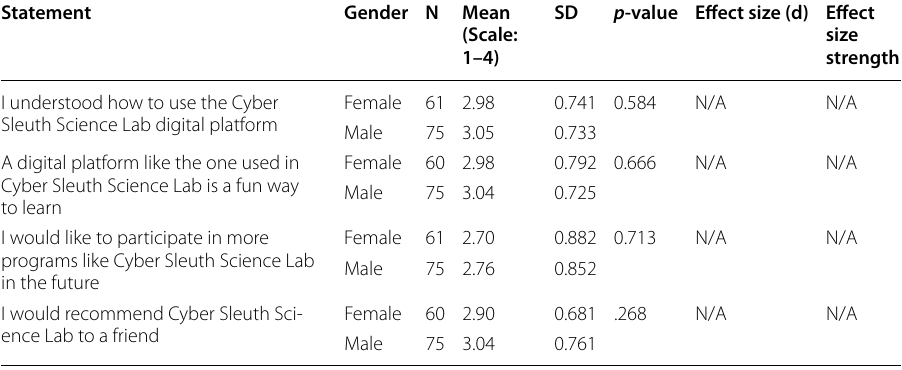
Table 5 Independent samples t-test comparison by gender of students’ satisfaction based on retrospective pre-post survey